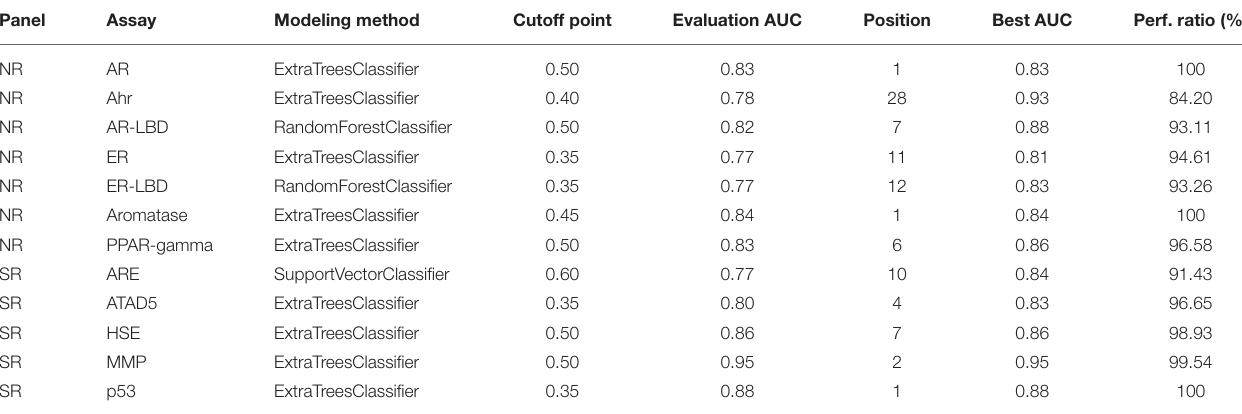
TABLE 4 | Performance comparison of final solution and winning solution on all assays.